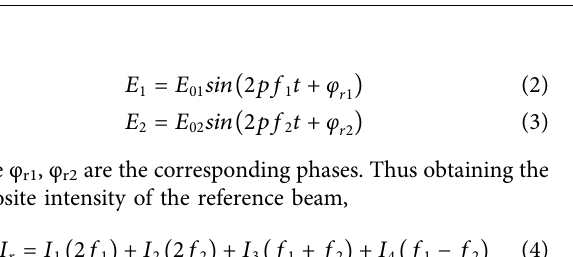
FIGURE 2 | (A) Schematic diagram of optical path and (B) experimental setup diagram of non-polarized laser heterodyne interference. BS: Beam splitter, M: Re fl ector, AOM: acousto-optic modulator, PD: